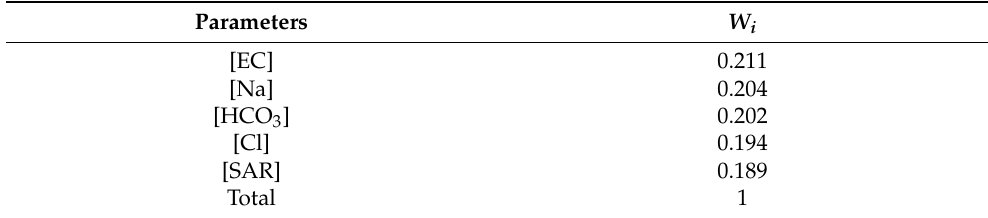
Table 2. The weights of the IWQI